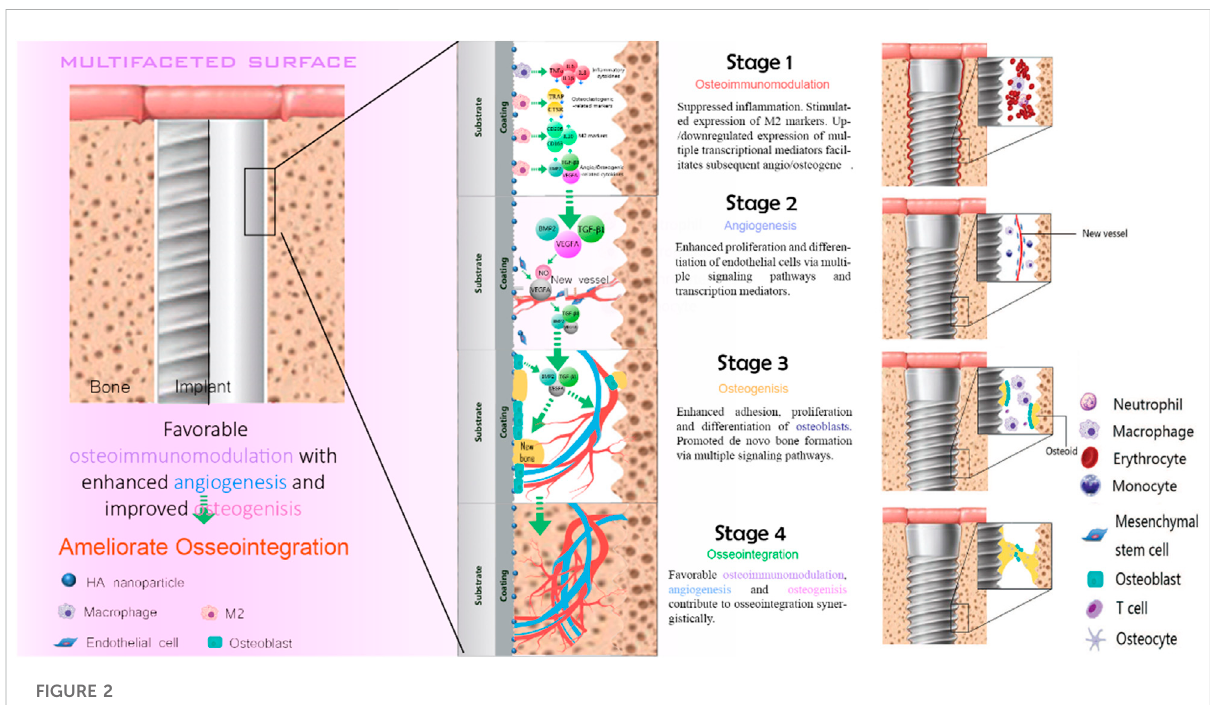
FIGURE 2 Schematic diagram of